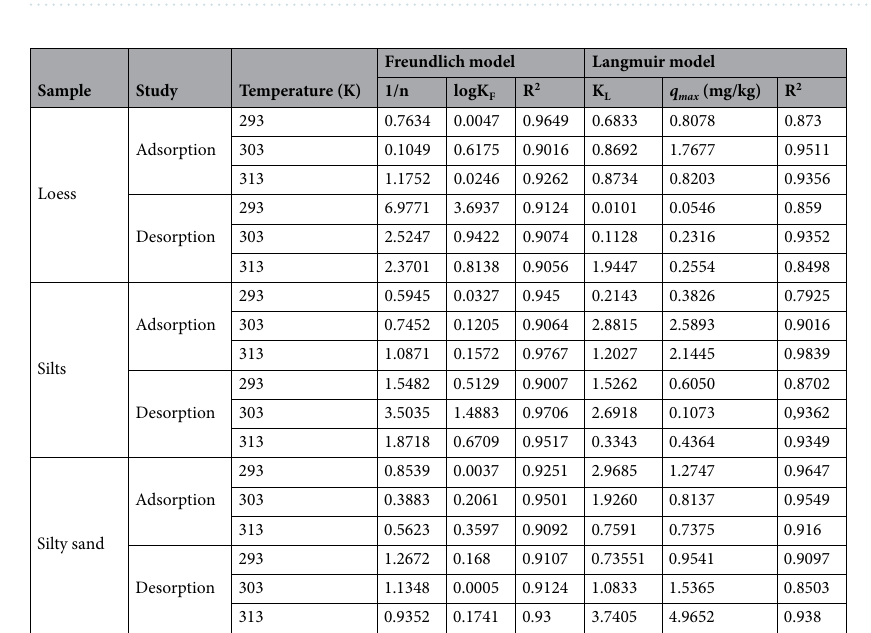
Figure 3. ( a )20 °C adsorption isotherms for phenanthrene in soils. ( b )30 °C adsorption isotherms for phenanthrene in soils. ( c )40 °C adsorption isotherms for phenanthrene in soils. ( d ) 20 °C desorption isotherms for phenanthrene in soils. ( e ) 30 °C desorption isotherms for phenanthrene in soils. ( f ) 40 °C desorption isotherms for phenanthrene in soils.